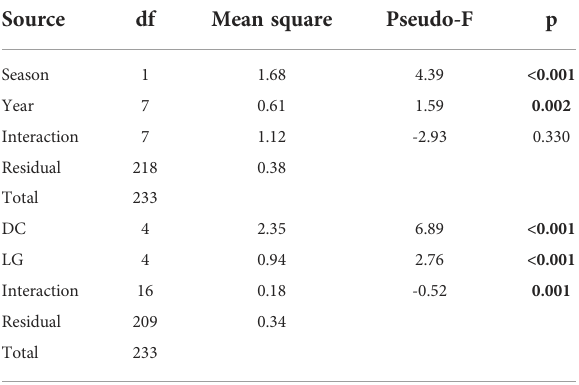
TABLE 2 PERMANOVA results for the 4 krill taxa, considering season, year, distance from the coast (DC) and latitudinal group (LG) as potential structuring